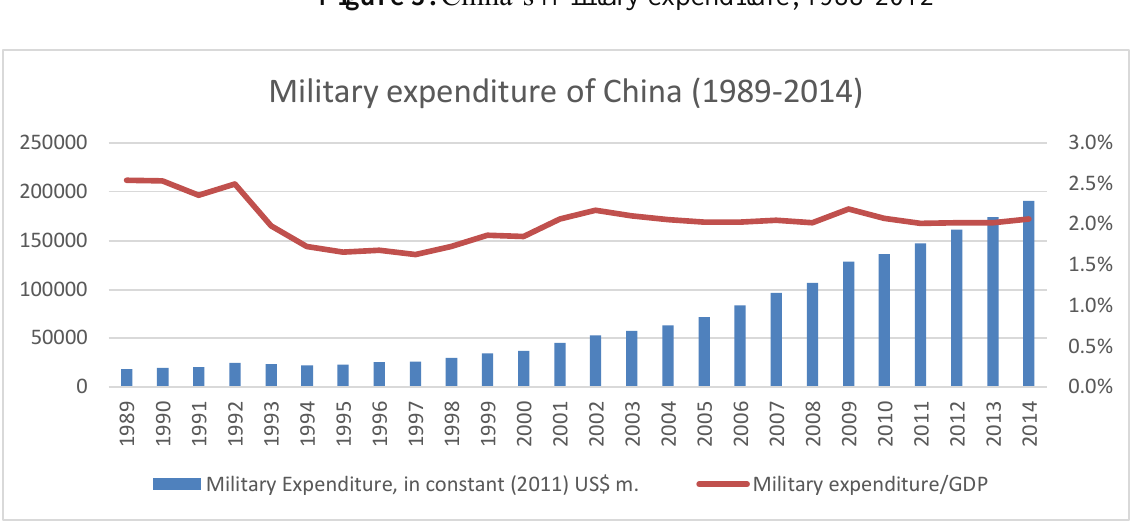
Figure 3. China’s Military expenditure,